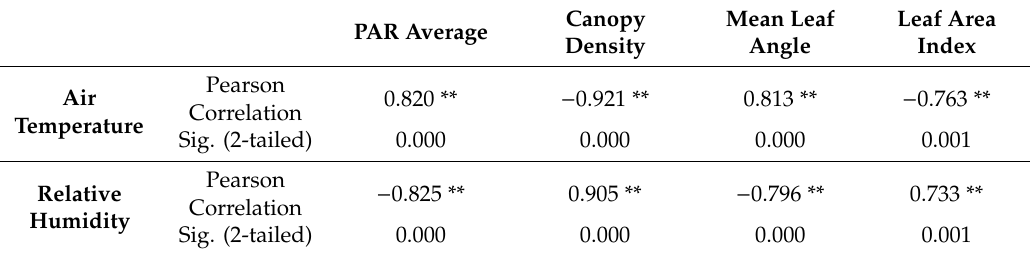
Figure 7. Matrix scatter illustration of six parameters and the pairwise correlation between each element. Table 3. Pearson correlation coe ffi cients of the characteristics of surface type on AT and